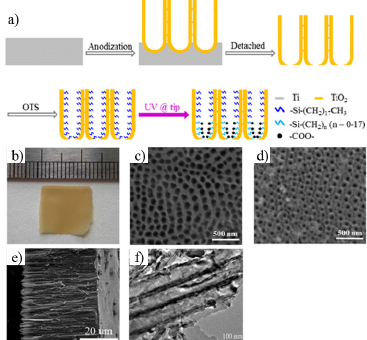
Figure 14. Fabrication of a TiO 2 nanochannel membrane. ( a ) Schematic flow chart of the